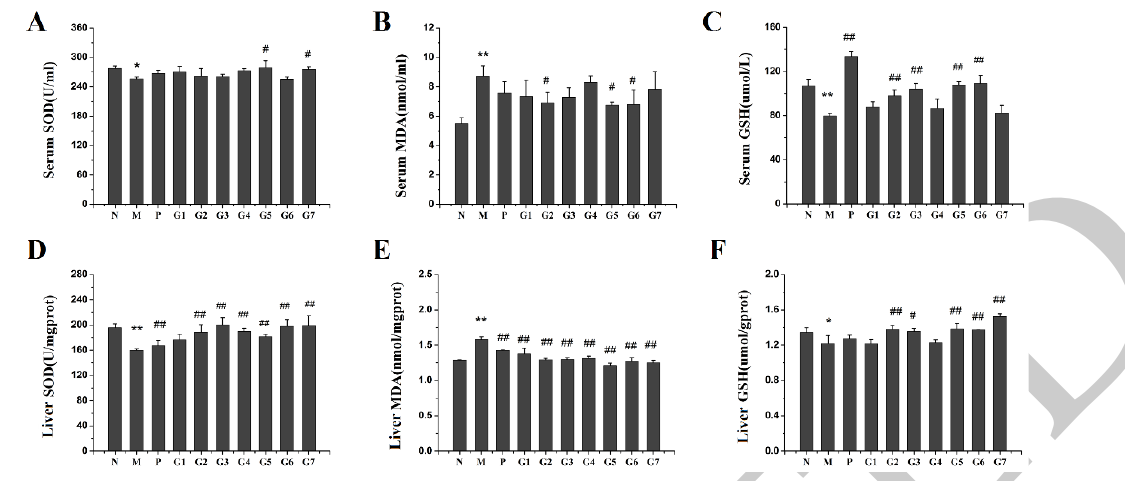
Figure 4. The effect of GA on oxidative stress. Levels of Serum SOD ( A ); Serum MDA ( B ); Serum GSH ( C ); Liver SOD ( D ); Liver MDA ( E ); and Liver GSH ( F ) were determined after GA treatment. N: normal group, M: model group, P: silybin positive group, G1: 18α-GA:18β-GA = 10:0, G2: 18α-